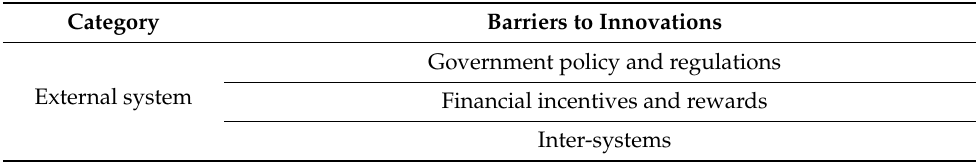
Table 1. Common barrier to the adoption of innovations. Source: Adopted from